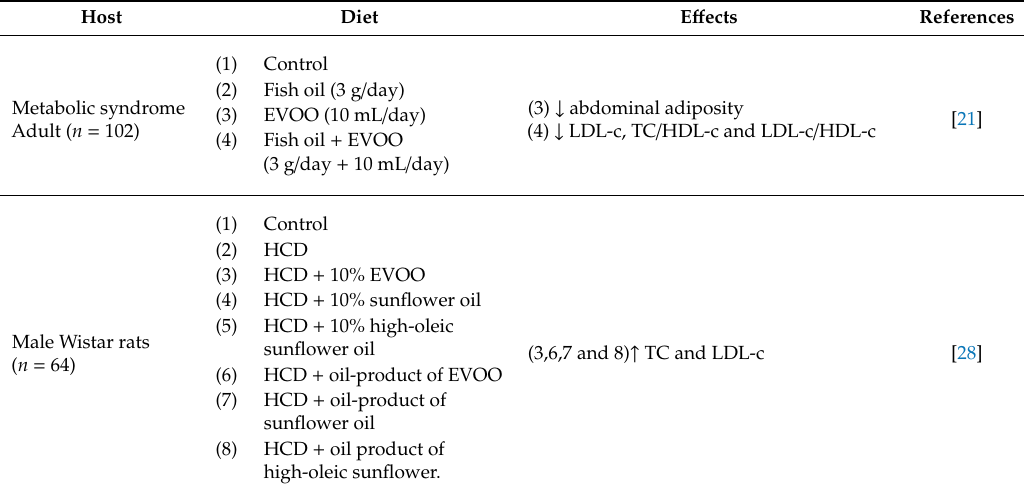
Table 1. E ff ects of the consumption of olive oil and its minor components in cardiovascular events and related